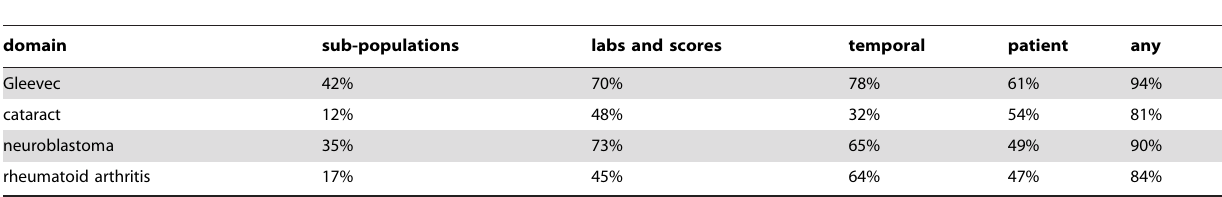
Table 3. Computationally challenging elgibility